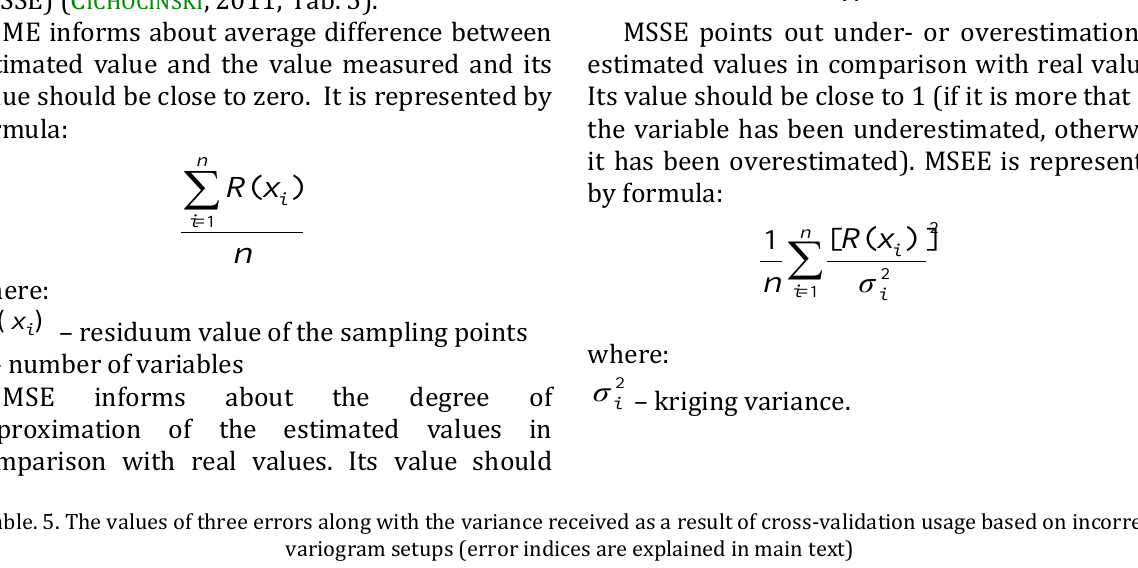
Table. 5. The values of three errors along with the variance received as a result of cross-validation usage based on incorrect variogram setups (error indices are explained in main text)